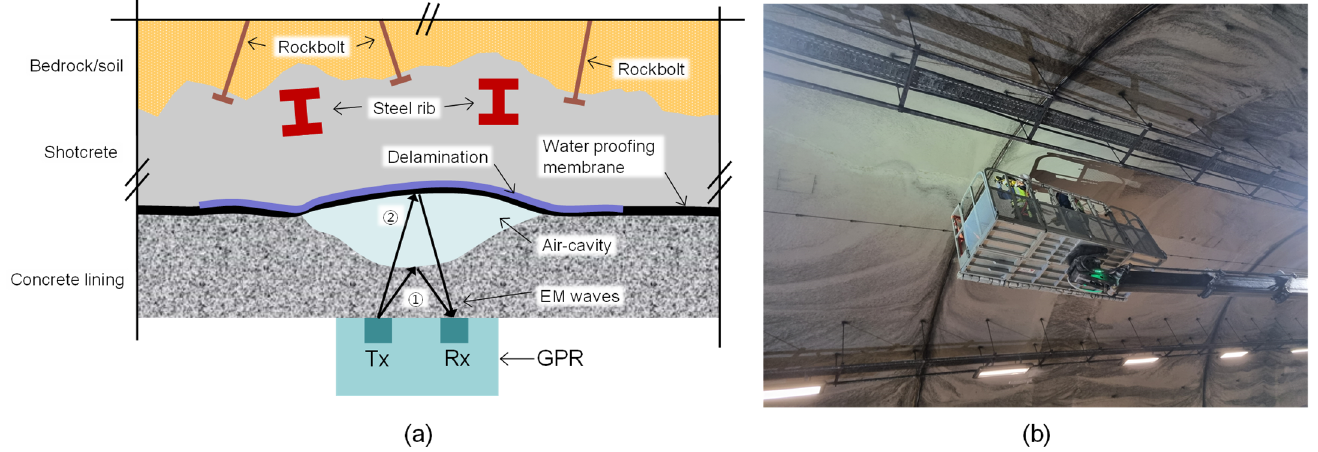
Figure 1. GPR survey on the surface of concrete tunnel lining: ( a ) a conceptual drawing of a concrete tunnel lining section, including an air-cavity behind concrete lining, and ( b ) a photograph of GPR survey on the crown of concrete lining in an actual tunnel structure in Korea.